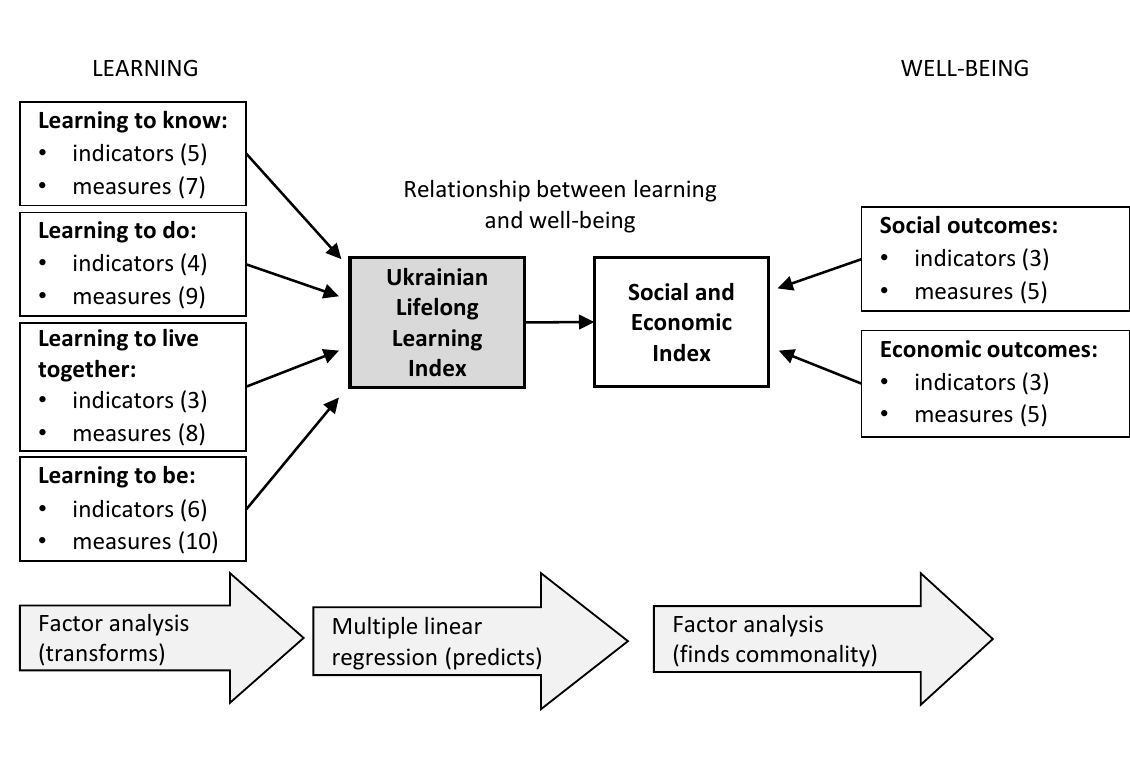
Figure 1. Model of Ukrainian Lifelong Learning Index